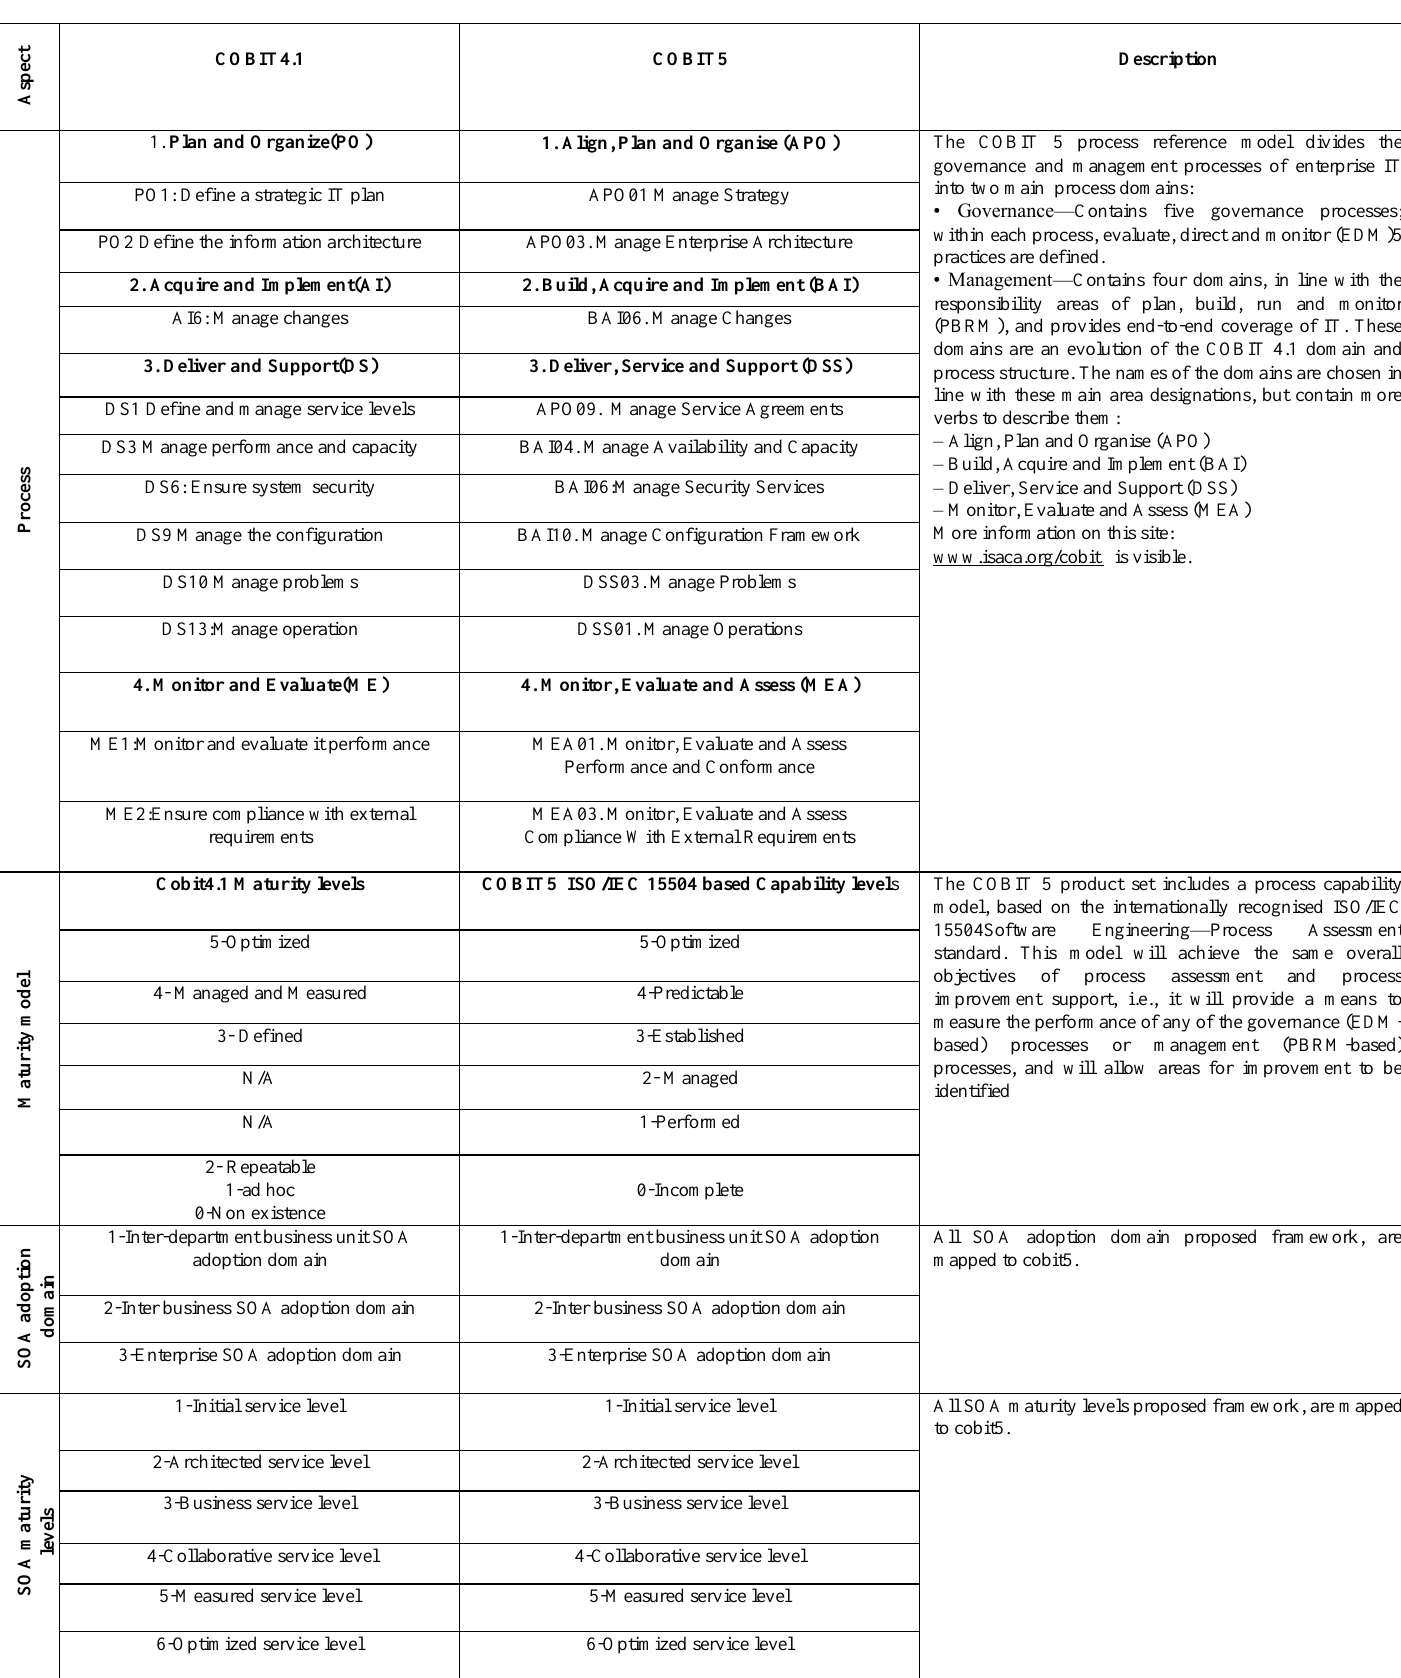
Table 5: Mapping proposed framework,